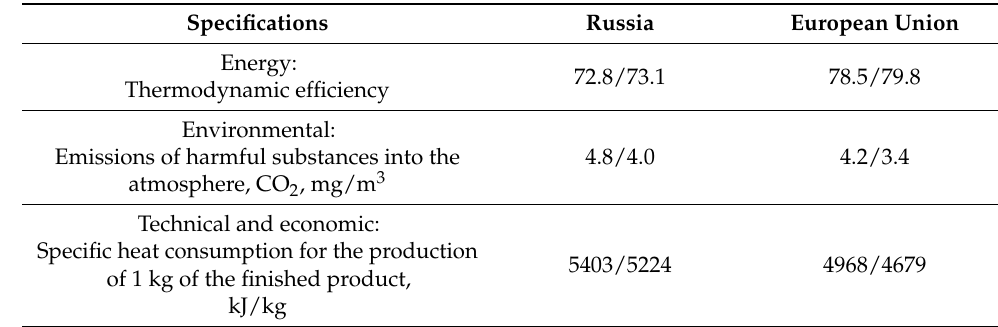
Table 1. Comparative characteristics of total efficiency of rotary kilns for the production of cement clinker/recycling of raw materials